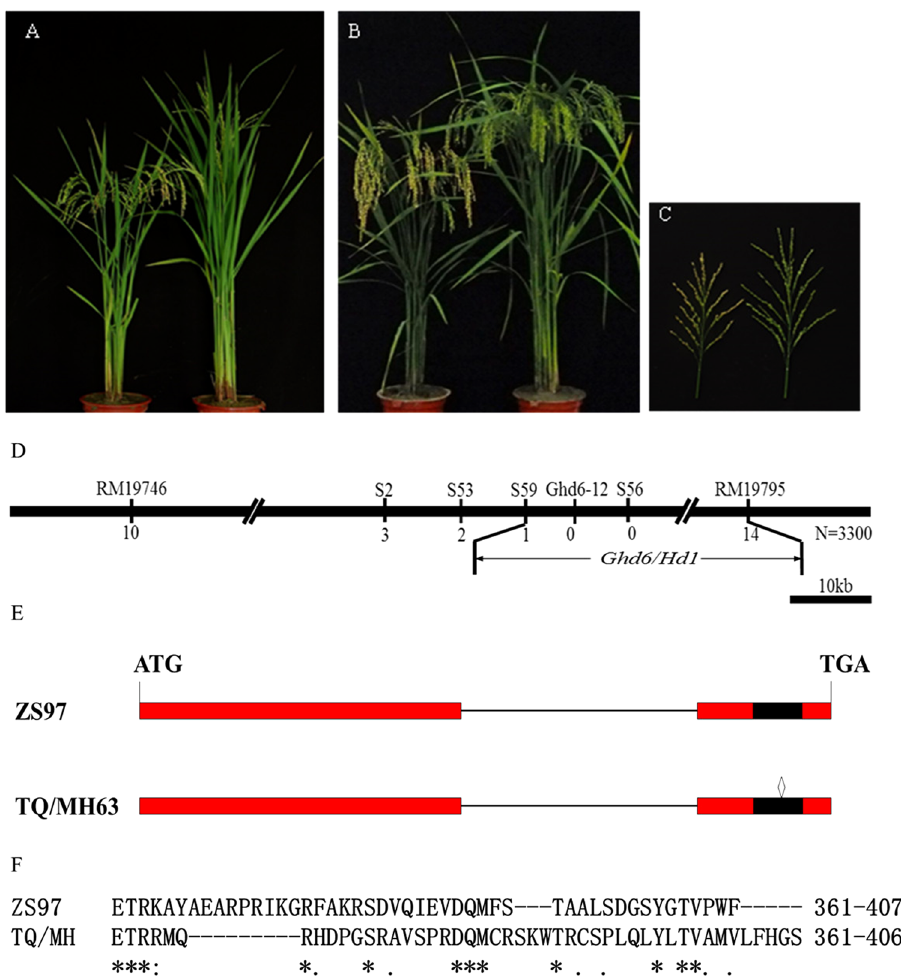
Figure 1. Performance of near isogenic lines of Ghd6 / Hd1 and map-based cloning of Ghd6 / Hd1 . ( A ) Phenotype of the whole plants for NIL-ZS (left) and NIL-TQ (right), ( A ) the picture was taken when NIL-TQ was flowering; ( B ) the picture was taken when NIL-ZS was ripening; ( C ) main panicles for NIL-ZS (left) and NIL-TQ (right); ( D ) Map-based Cloning of Hd1 ; ( E ) comparison sequences of Hd1 of Teqing/Minghui 63 allele and Zhenshan 97 allele. The red rectangle represents the coding region of Hd1 . The black region means the CCT domain of Hd1 from + 1012 bp to + 1146 bp. The black line means the intron. Diamond indicates the position of a 4-bp (AAAG) deletion in CCT domain on + 1089 site. ( F ) The frame shift mutation in CCT domain in Teqing and Minghui 63